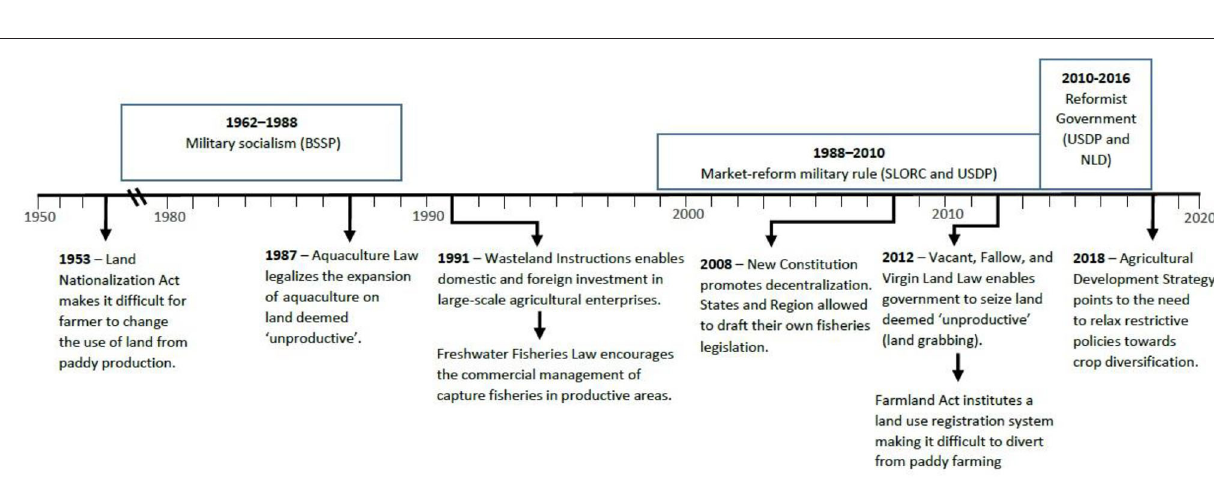
FIGURE 5 | Timeline of events that influenced and ultimately restricted rice-fish production practices in Myanmar.